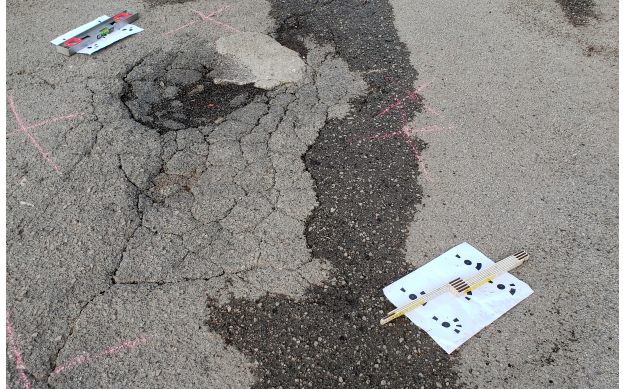
Figure 5. Distressed section 2.